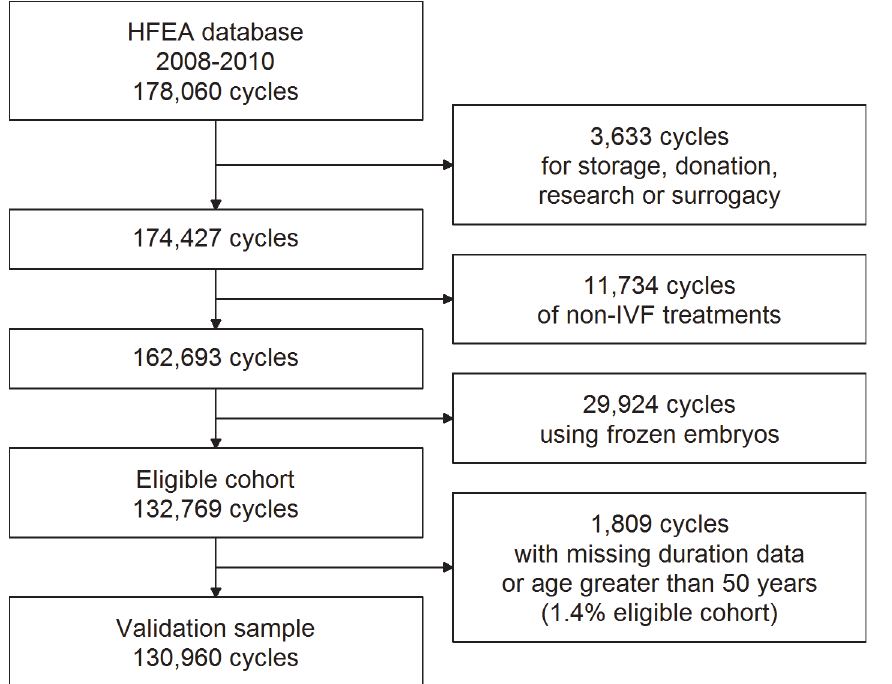
Fig 1. Inclusion/exclusion criteria and formation of the validation